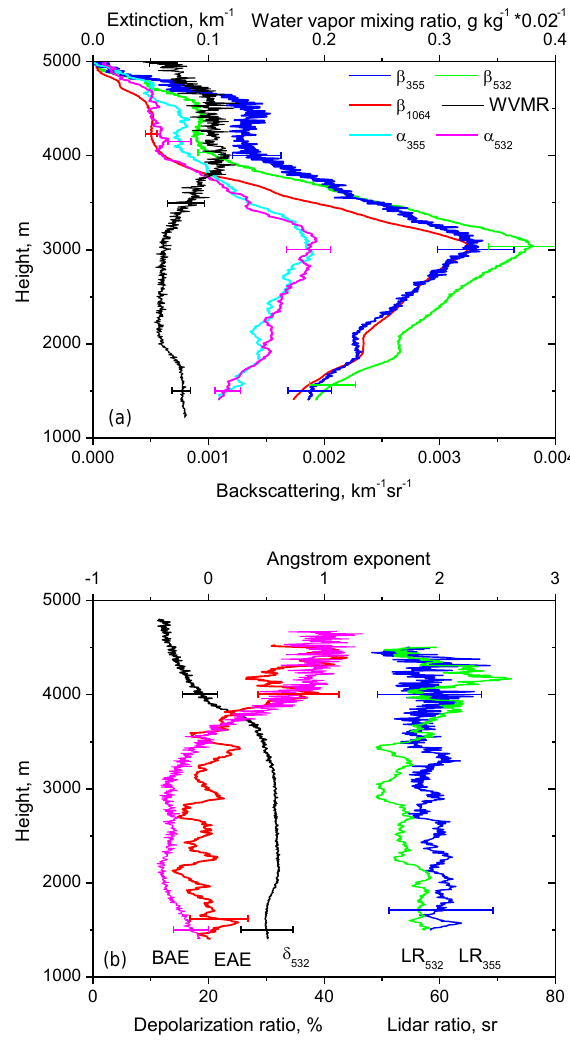
Figure 15. Vertical profiles of (a) backscattering and extinction co- efficients and (b) depolarization ratio, backscattering and extinction Ångström exponents at 355/532nm measured on 10 April 2015 for the period of